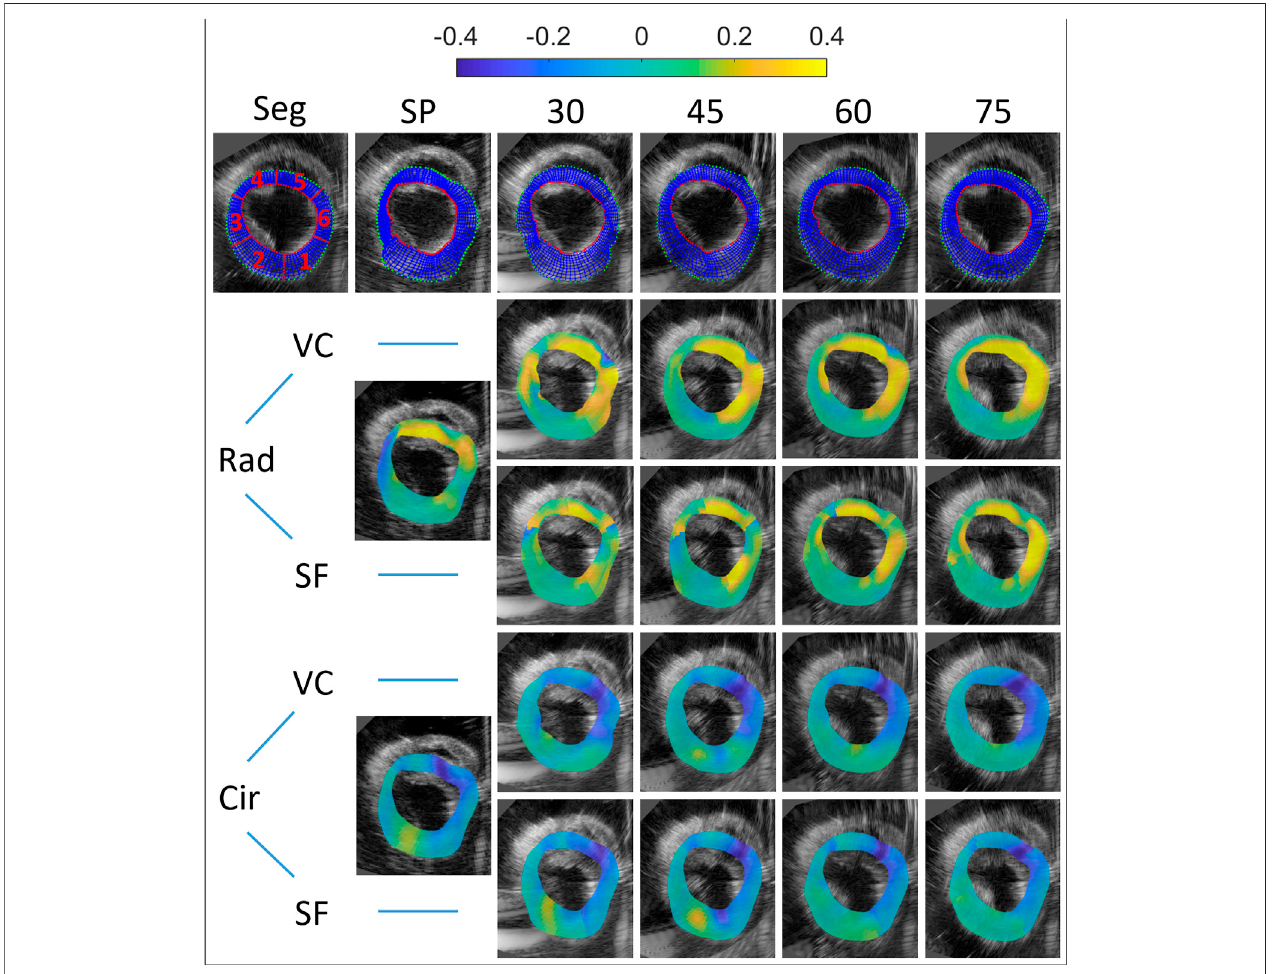
FIGURE 7 | Motion tracking and end-systolic strain for all multi-perspective datasets (relative angles 30 ° – 75 ° ). Top row: the initial segmentation mesh ( fi rst frame), and fi nal tracked meshes at end-diastole are shown (SP and 30 ° – 75 ° ). Both radial and circumferential end-systolic strain images are shown for single-perspective imaging (SP), and multi-perspective strain imaging using unit axial vectors based compounding (VC) and strain fusion (SF), respectively.